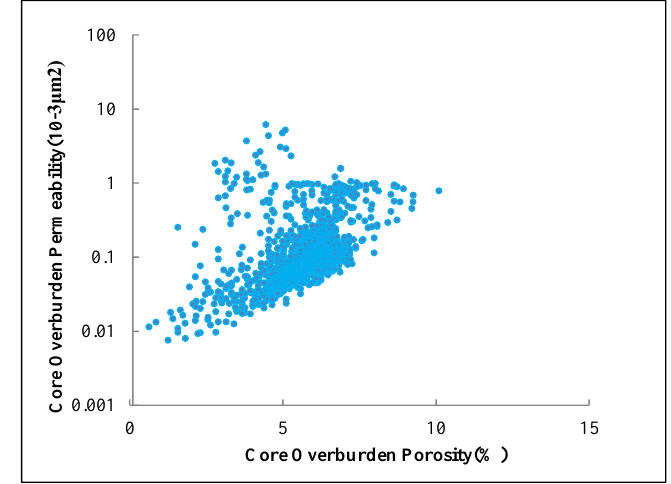
Figure 4. The relationship between porosity and permeability in the study area.